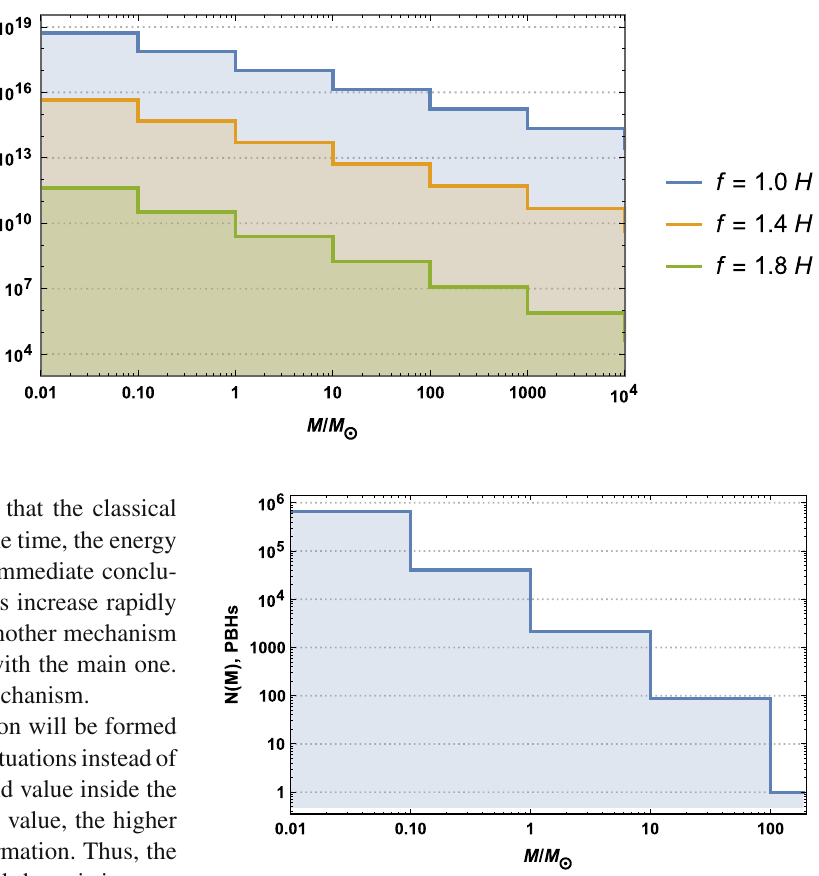
Fig. 2 The PBH mass distribution for the cluster with a central PBH of the mass 10 2 M (cid:2) . with the model parameter value f = 1 . 4 H . Y-axis shows the total number of PBHs in each mass interval